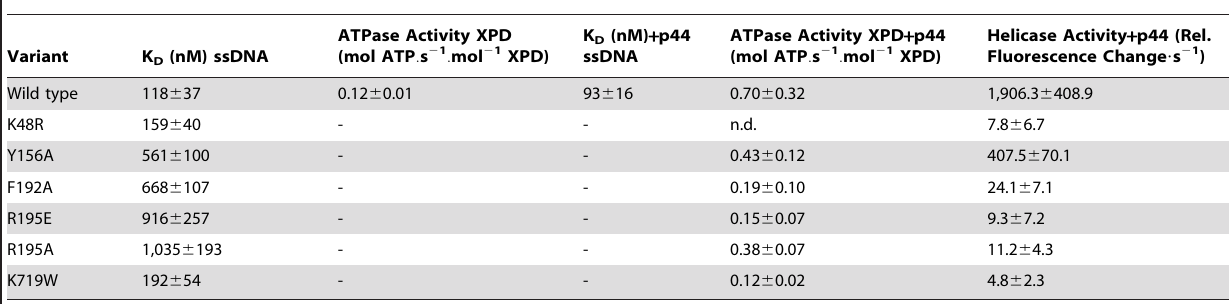
Table 2. Biochemical parameters of ctXPD and